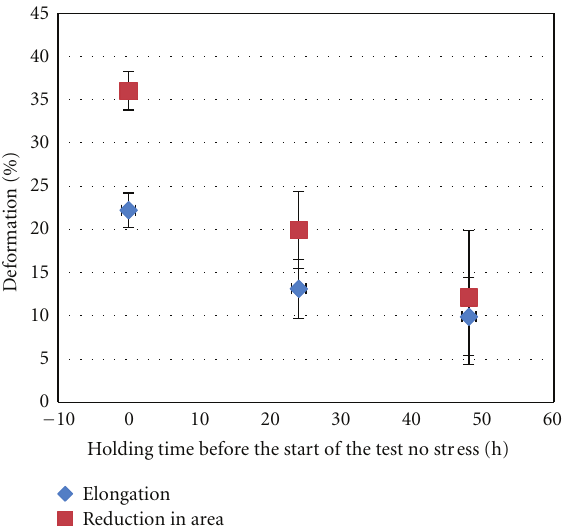
Figure 15: The embrittling of the steel as a function of the time of exposure prior to testing at 45 ◦ C and 800